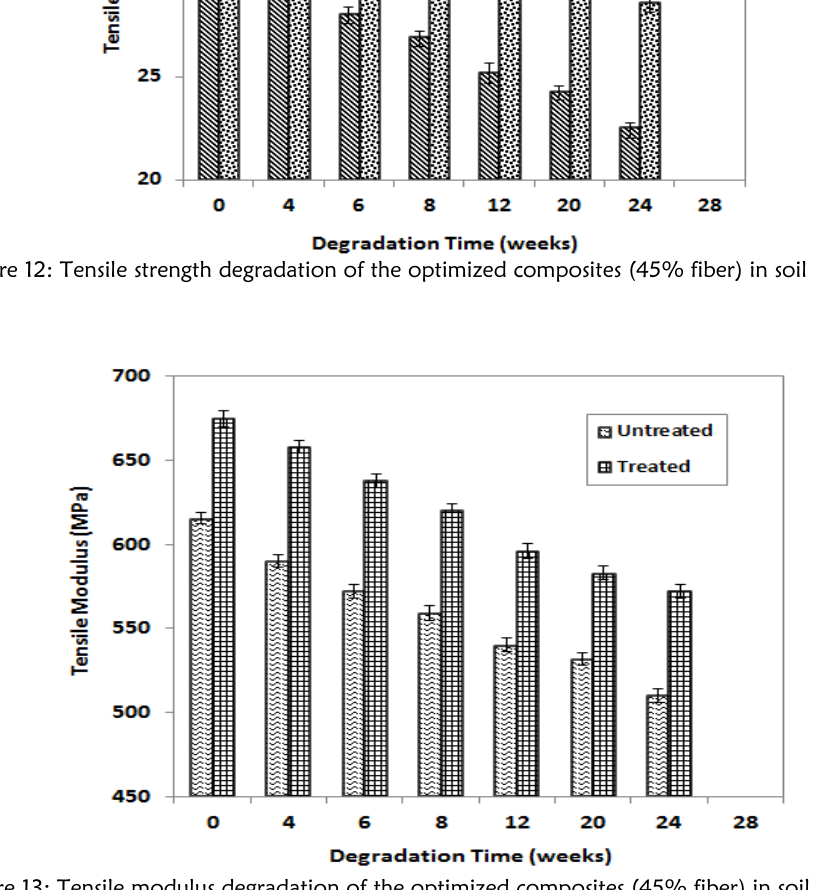
Figure 13: Tensile modulus degradation of the optimized composites (45% fiber) in soil